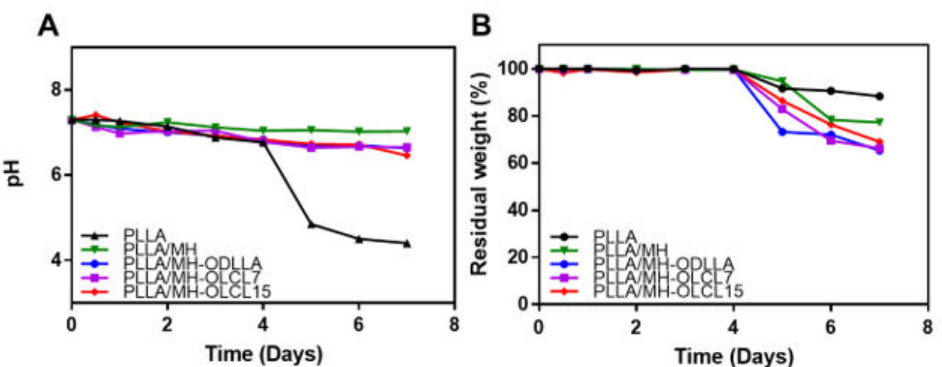
Figure 5. The changes of ( A ) pH and ( B ) residual weight (%) during degradation in proteinase K solution for 7 days at 37 ◦